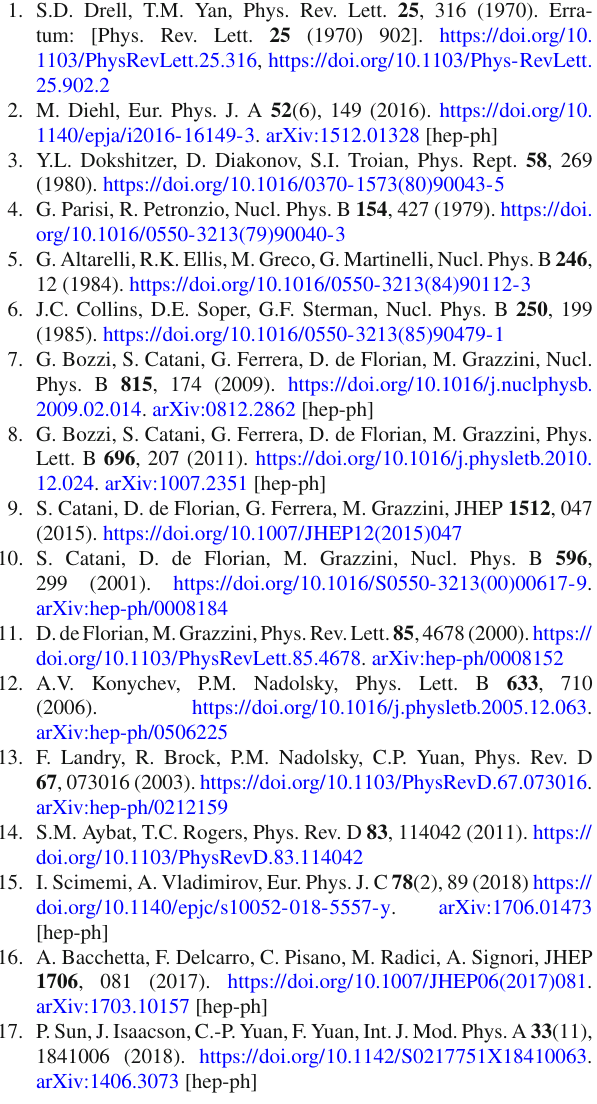
Fig. 6 Top panel: lepton pair average transverse momentum, (cid:14) q 2 a function of x F integrated in the mass range 4 . 0 < M / GeV < 8 . 55. (cid:15) as a function of M integrated in the range 0 < Bottom panel: (cid:14) q 2 T x F < 1. Averaged values are obtained integrating both predictions and the phenomenological parametrisation of the data up to q max